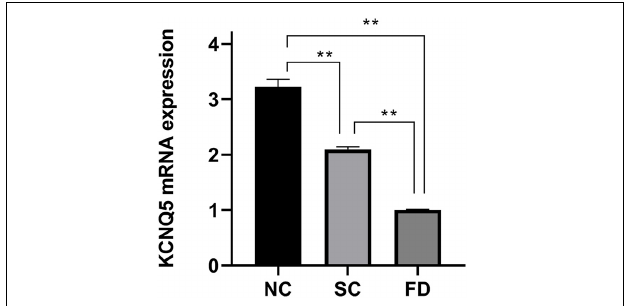
FIGURE 2 | Measurement of KCNQ5 expression at mRNA level after 4 weeks of treatment. (Histogram analysis indicated that the KCNQ5 mRNA level in FD group significantly decreased after 4 weeks of form deprivation. ** P < 0.01).